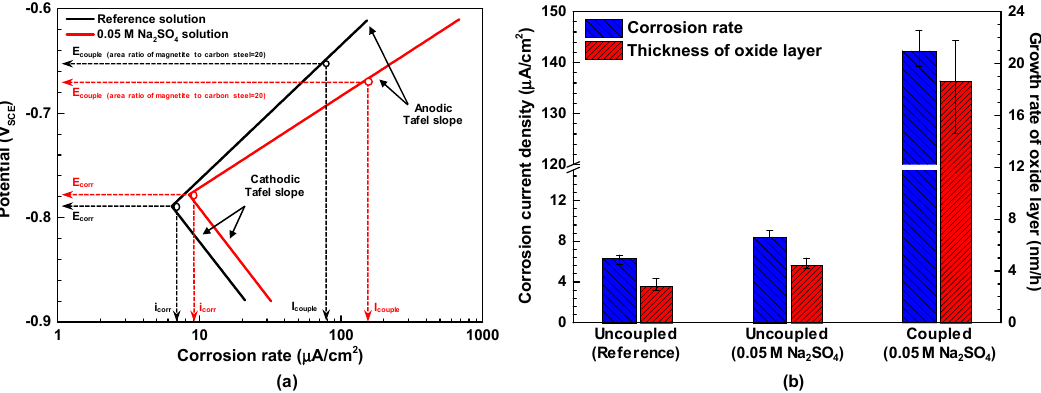
Figure 8. ( a ) Schematic polarization curves for the estimation of corrosion rate and ( b ) relationship between corrosion rate and oxide growth rate.